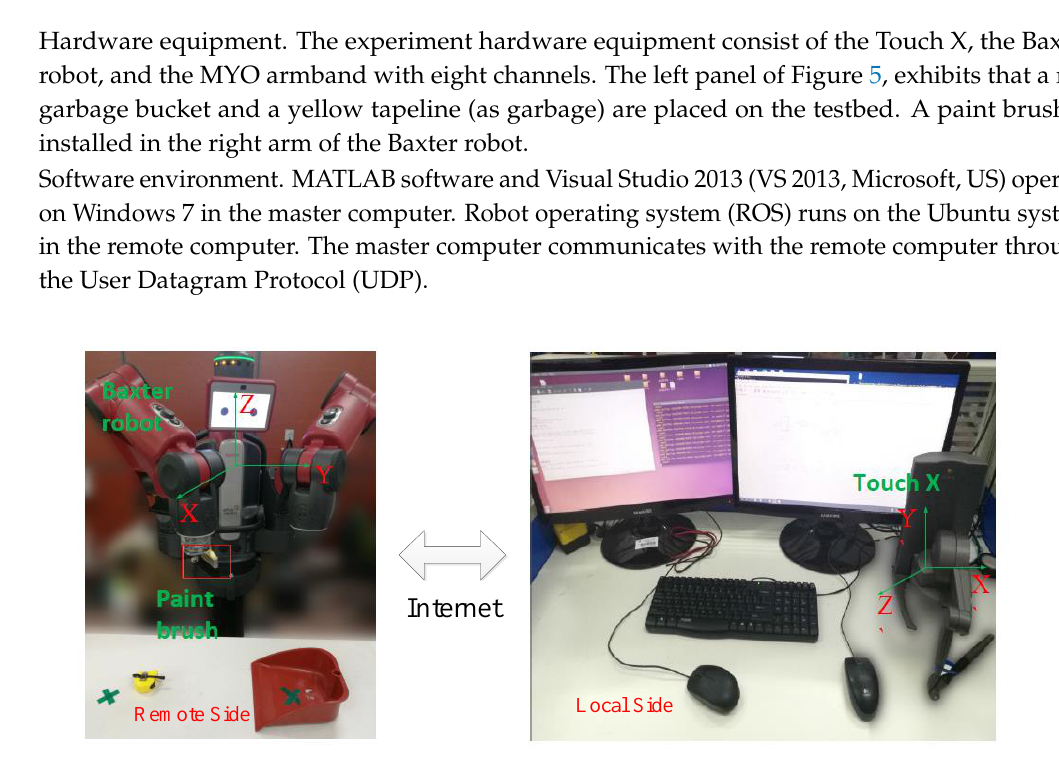
Figure 5. Experimental setup in this